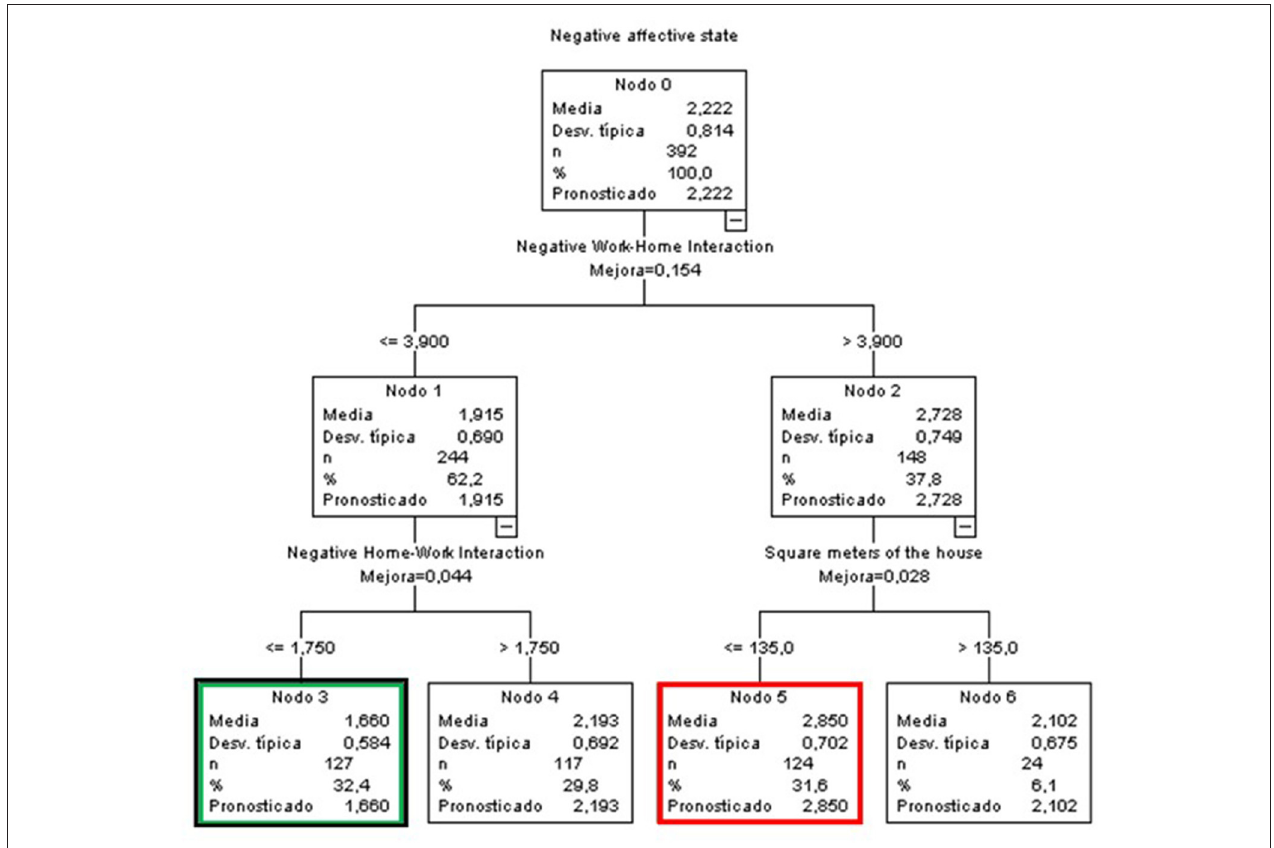
FIGURE 6 | Classificatory tree of negative affective states (T&R).